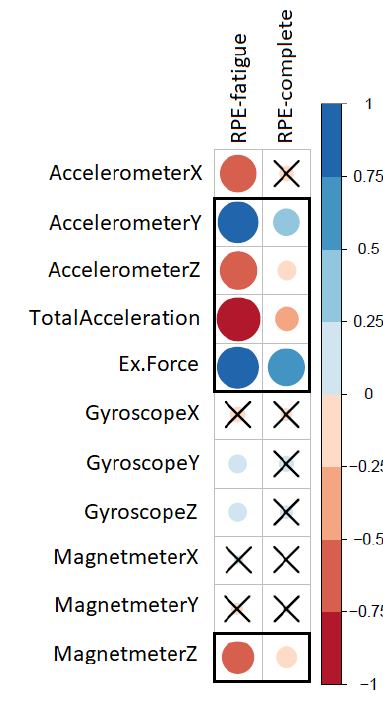
( c ) Correlation matrix of the AAD fea- tures and RPE.